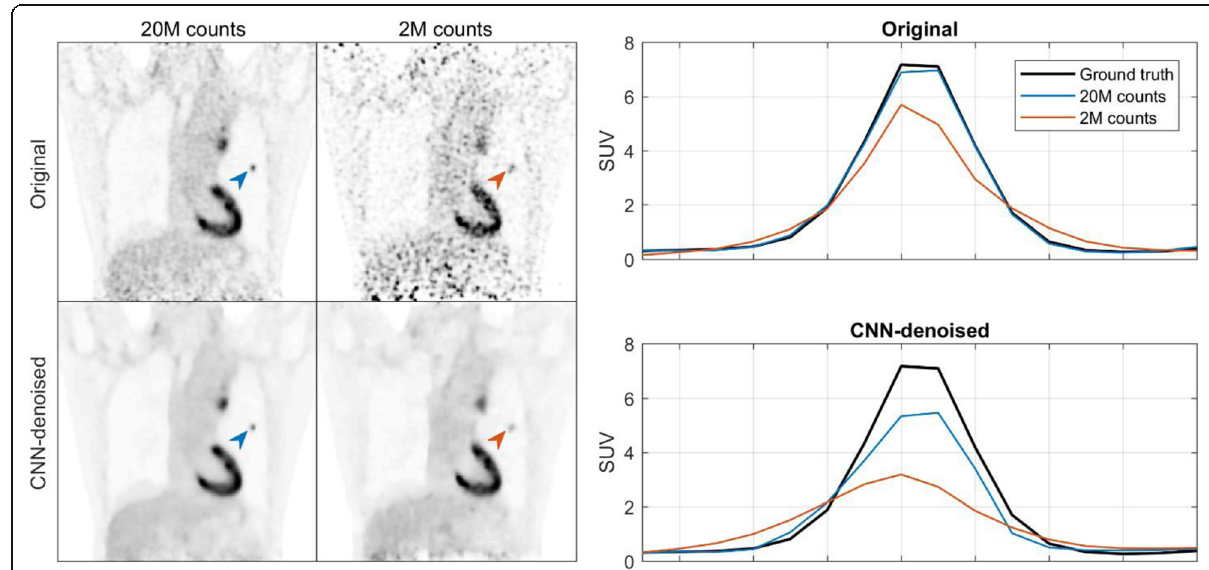
Fig. 4 Example showing a small lesion (0.3 cm 3 ) where its uptake was not fully recovered by the